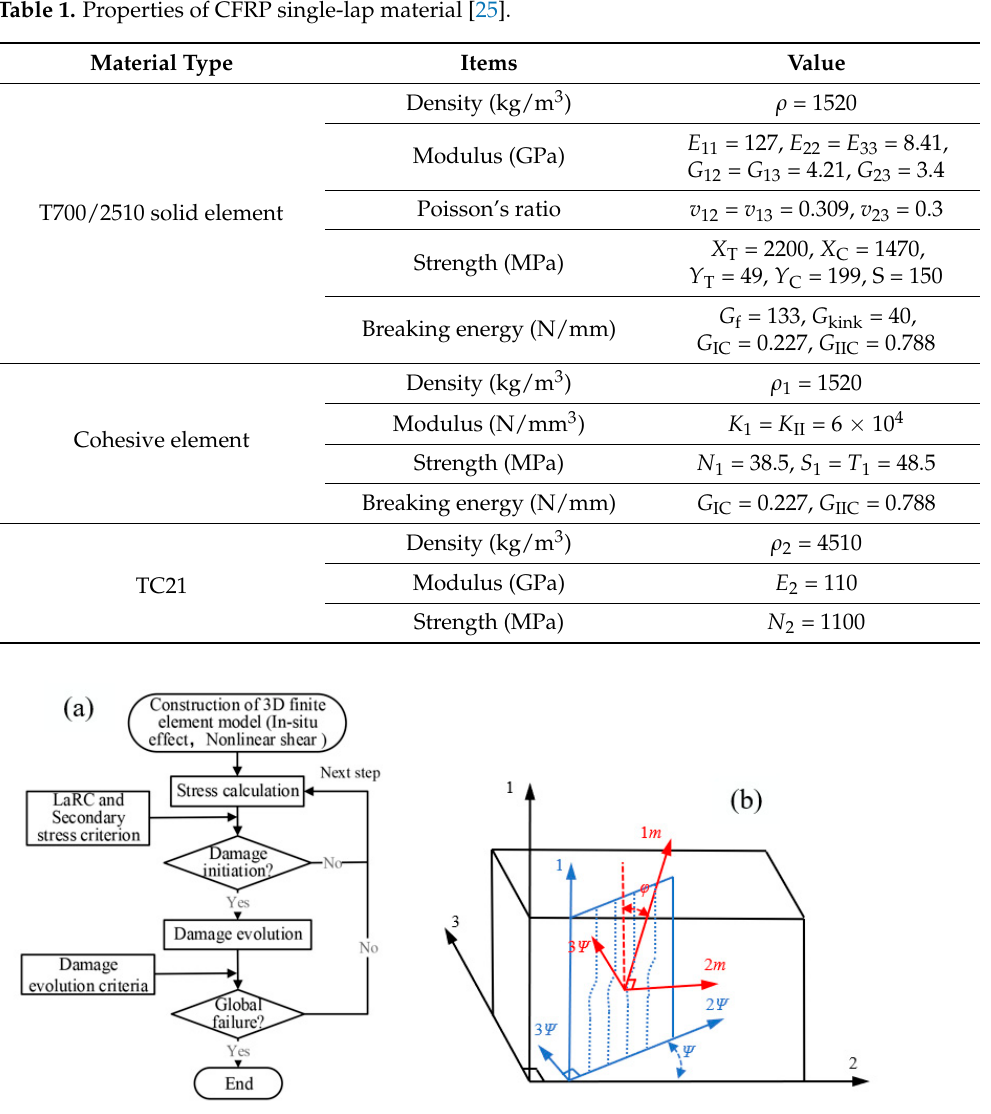
Figure 3. ( a ) Flow chart of numerical calculation; ( b ) fiber kinking coordinate conversion diagram.